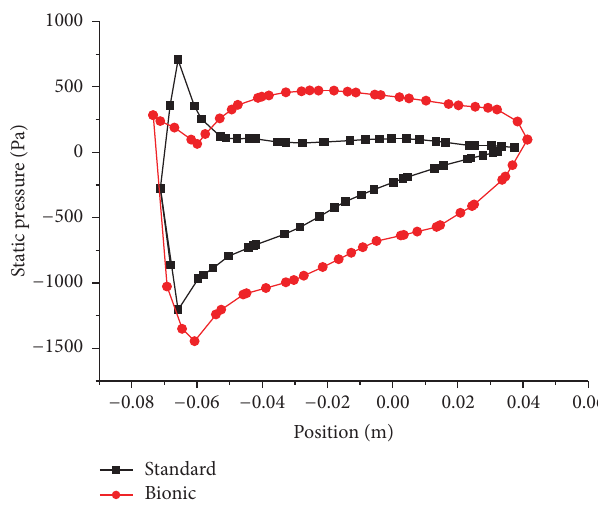
Figure 19: Static pressures on windward surfaces of the